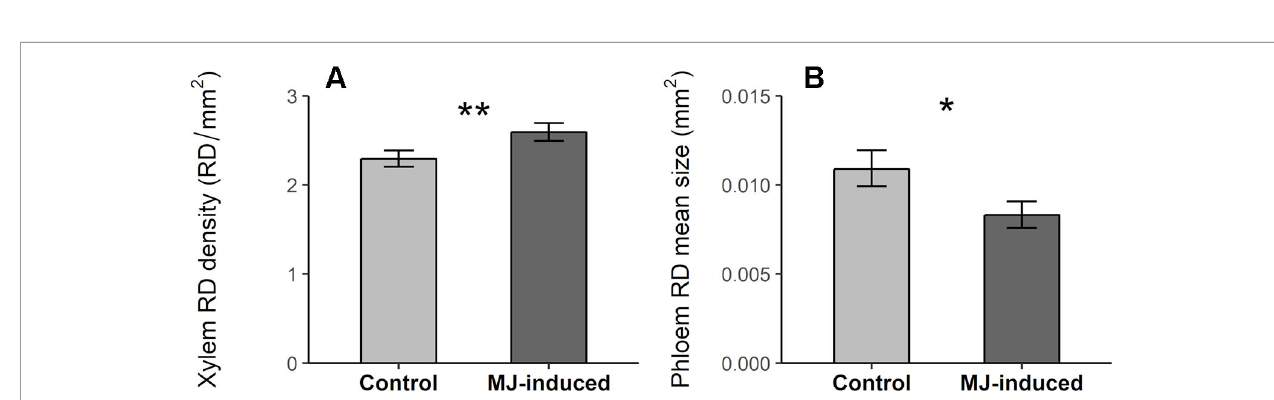
FIGURE 4 | Resin duct density (RD density, RD/mm 2 ) in the xylem (A) and resin duct mean size (RD mean size, mm 2 ) in the phloem (B) in MJ-induced (N = 67) and control plants (N = 63) of Pinus pinaster from 10 populations. Bars represent least square means ± SE extracted from the mixed model. Signi fi cant p-values computed from the corresponding mixed model are indicated with asterisks (p < .01**; p <